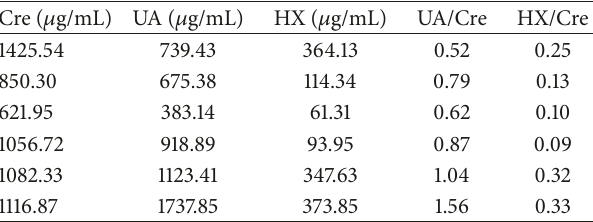
Table 4: Concentrations of uric acid (UA), hypoxanthine (HX), and creatinine (Cre) and the ratios for purine metabolite to creatinine in urine samples of six